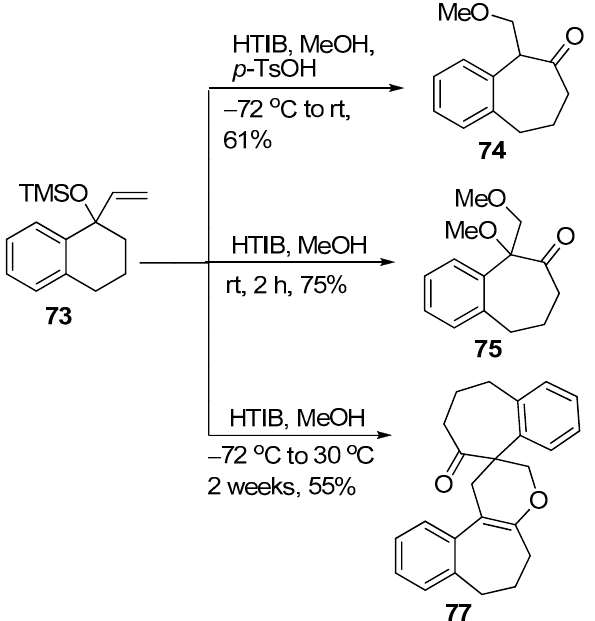
Scheme 23. Formation of seven-membered rings 74, 75 and 77 by ring expansion of 1-vinylcycloalkaol derivatives 73